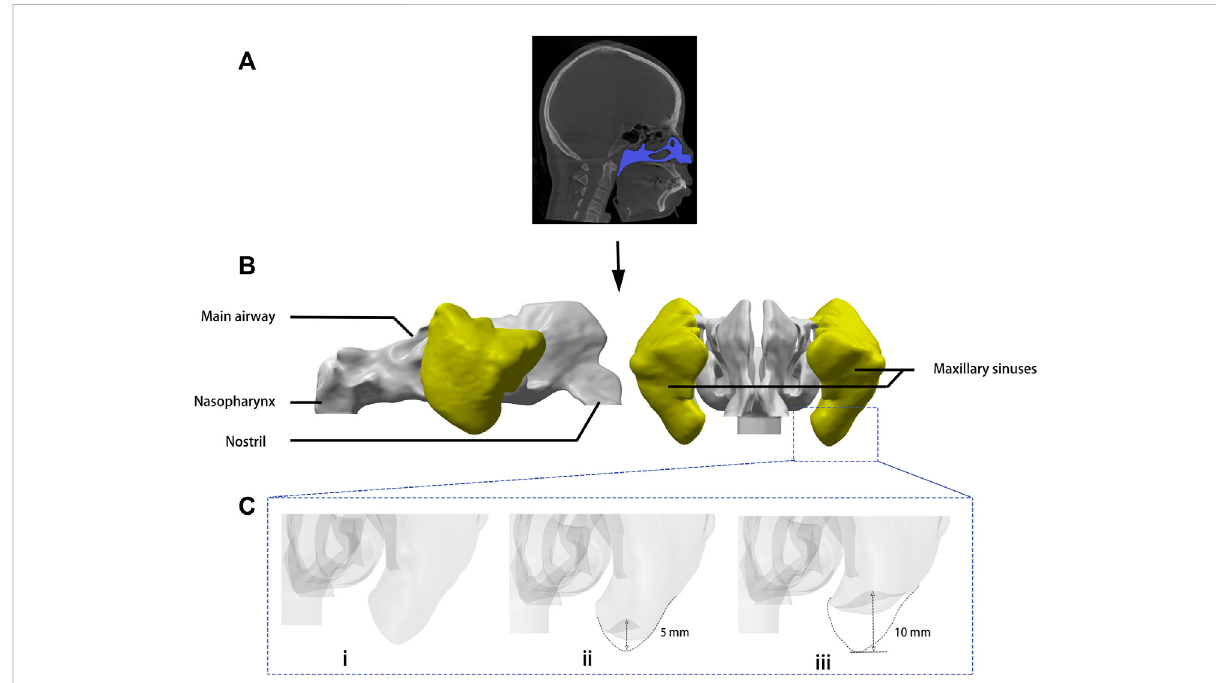
FIGURE 1 Digitalmodeling. (A) Imagesincludingthewholenasalcavityandmaxillarysinusesweretakenbyconebeamcomputedtomography. (B) Three- dimensional model of the airspace was rebuilt by medical imaging software. (C) Sinus augmentation was simulated by computer-aided design software: (i) model A: sinus fl oor of the presurgical model, (ii) model B: sinus augmentation through the transcrestal approach, (iii) model C: sinus augmentation through the lateral window